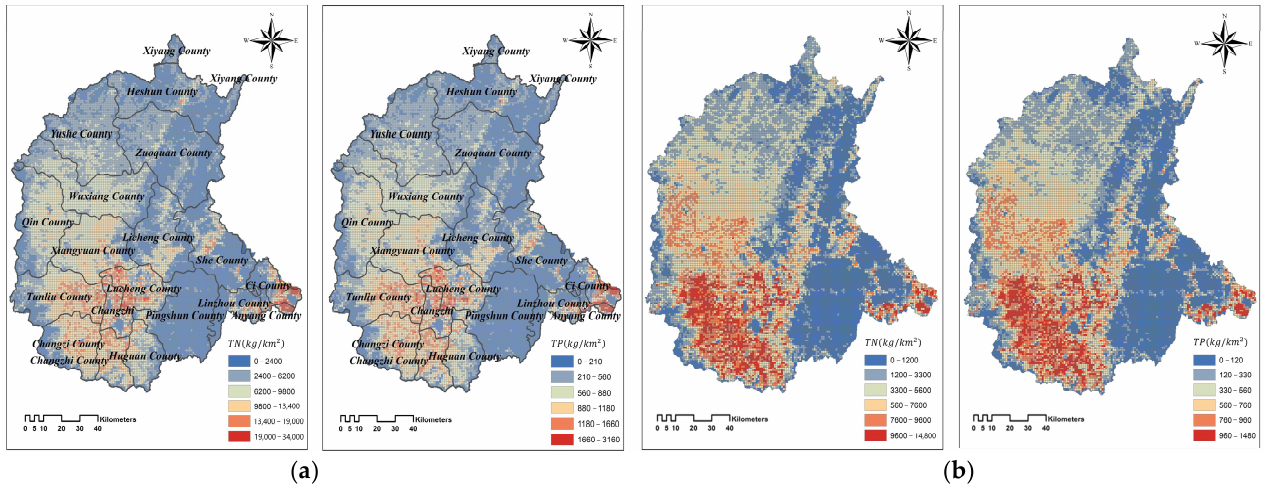
Figure 12. ( a ) Distribution map of NSP intensity estimated by the proposed method. ( b ) Distribution map of NSP intensity estimated by the traditional